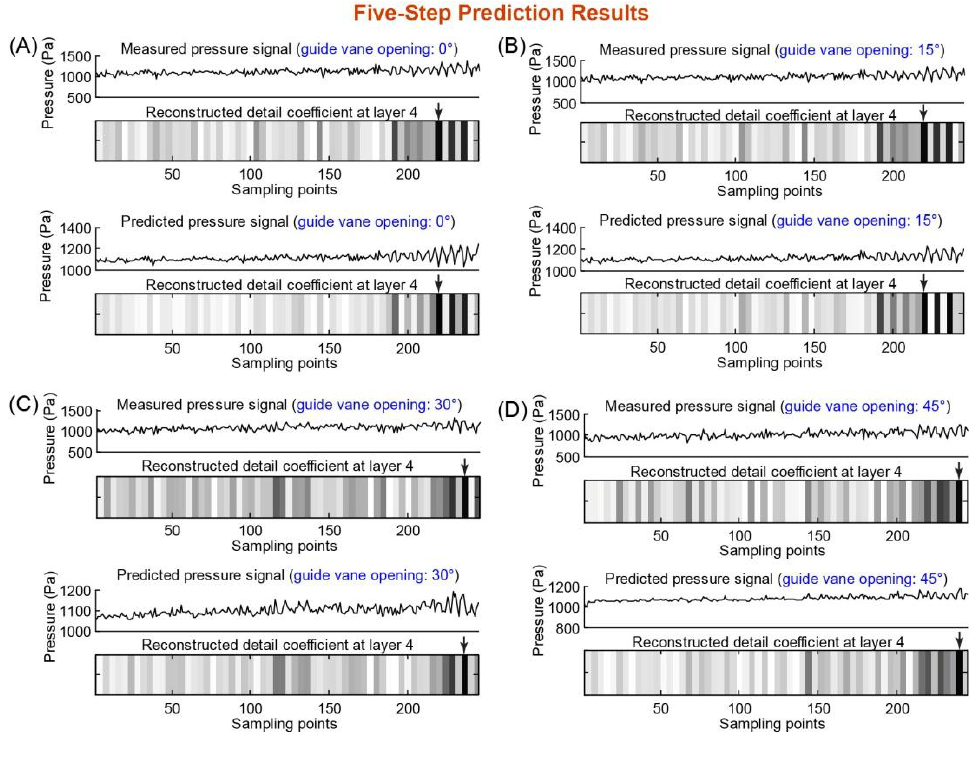
Figure 5. Five-step prediction results of the fan rotation stall at guide vane openings of 0°, 15°, 30° and 45° (panels ( A )–( D )). In each panel (( A )–( D )), the experimental measured pressure signal and its wavelet analysis result ( i.e ., fourth-layer detail coefficient) are shown on the top, and the SVRM-predicted pressure signal and its wavelet analysis result ( i.e ., fourth-layer detail coefficient) are shown on the bottom. The arrows on the fourth-layer detail coefficient plot indicate the starting points of the rotation